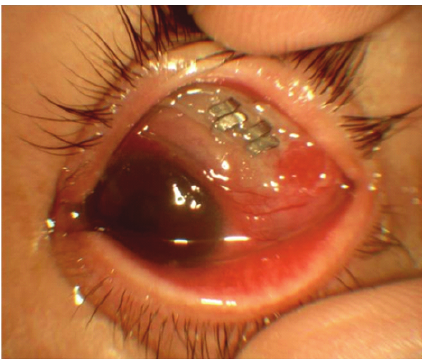
Figure 1: Photograph of the left eye at the time of presentation. An extrusion of the buckle which had migrated through the superior rectus muscle and infected sclera was observed through the conjunctival fistula.